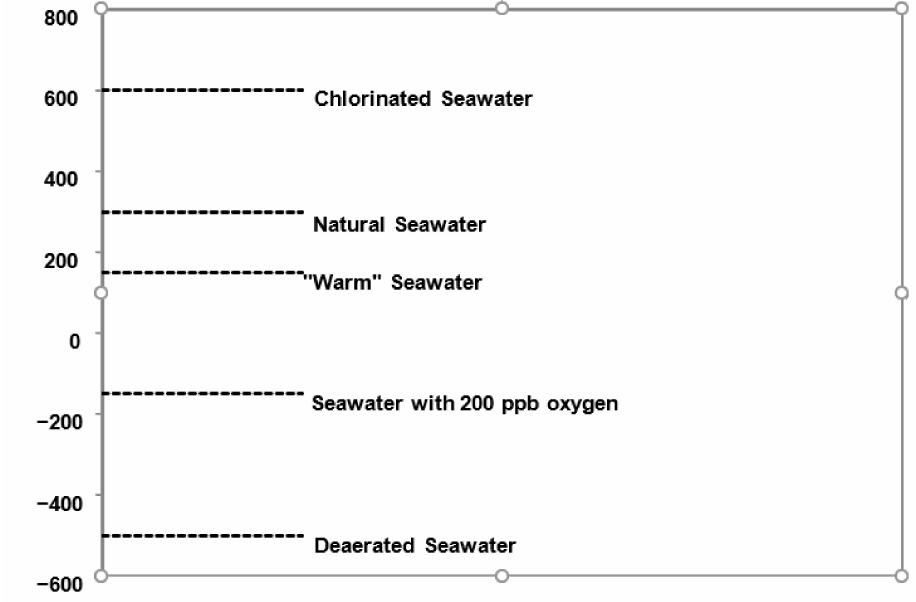
Figure 8. Potentials that can occur with stainless steels in seawater [54]. In natural seawater a biofilm forms over a period of a few days to a few weeks, which depolarizes the cathodic reaction (the reduction of dissolved oxygen), elevating the potential to around +300 mV SCE. If chlorine/hypochlorite is added to the seawater to control fouling, the biofilm does not form, but chlorine/hypochlorite is a powerful oxidizer and the potential rises to around +600 mV SCE. If the seawater is heated to 25 to 30 ◦ C above the normal ambient temperature, the biofilm does not form and the potential is then much lower, around +150 mV SCE (warm seawater). If the seawater is partially deaerated, then the potential falls further, and with 200 ppb oxygen it is around − 150 mV SCE. When the seawater is fully deaerated the potential is around − 500 mV